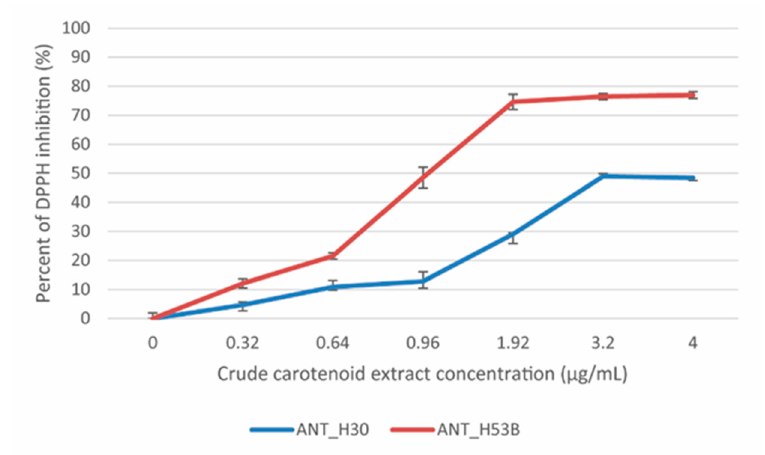
Figure 3. DPPH inhibition test performed using the ANT_H30 and ANT_H53B crude carotenoid extracts. Error bars represent standard deviations of the triplicates.